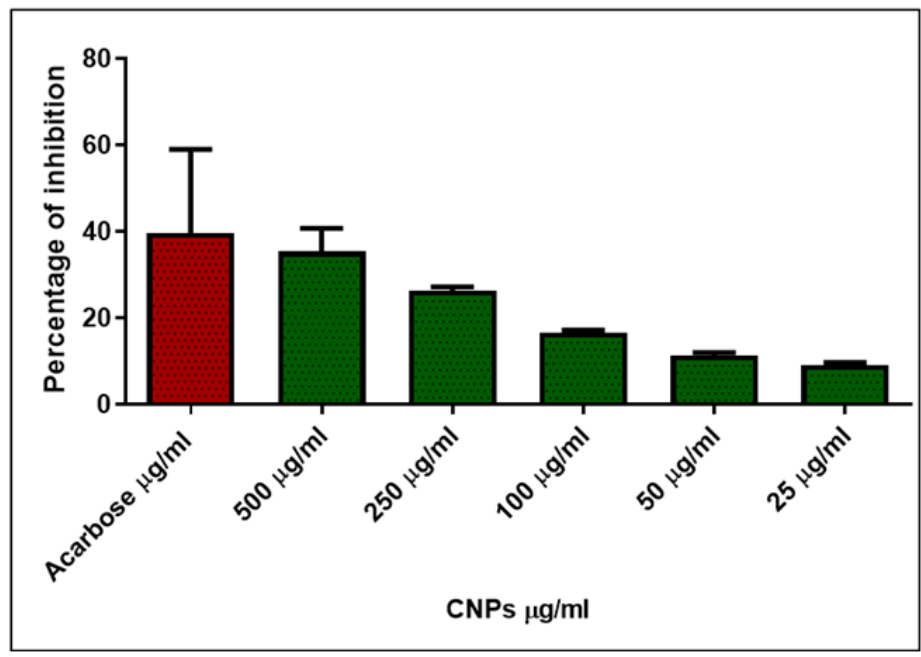
Figure 11. Percentage of α -glucosidase inhibitory activity assay with MAL-CNPs. Note: positive control: alphamylase + substrate; negative control: acarbose.